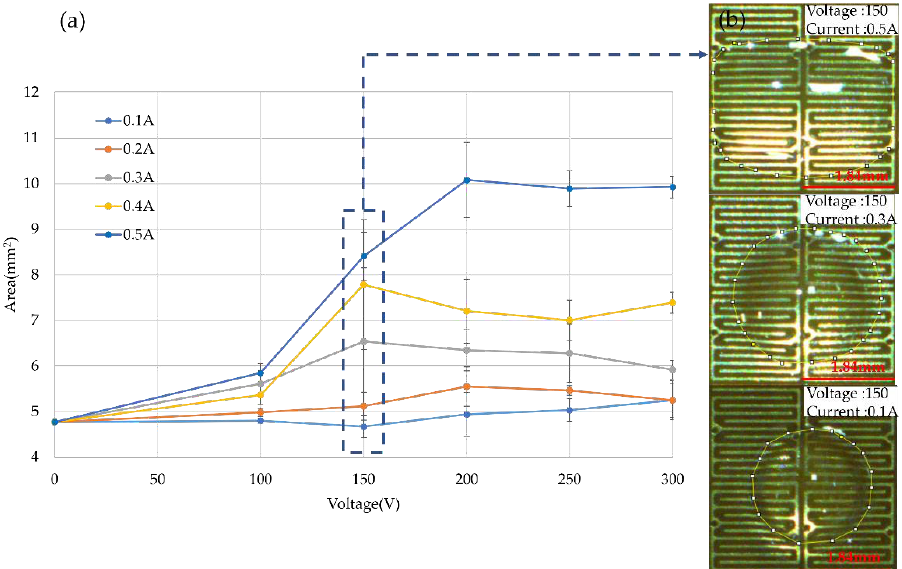
Figure 6. Droplet expanding experiment for current influence ( n = 5). ( a ) Droplet expanded area result with the current condition fixed. ( b ) Demonstrate the droplet expand situation when the current ranges from 0.1 A to 0.5 A at a voltage of 150 V.